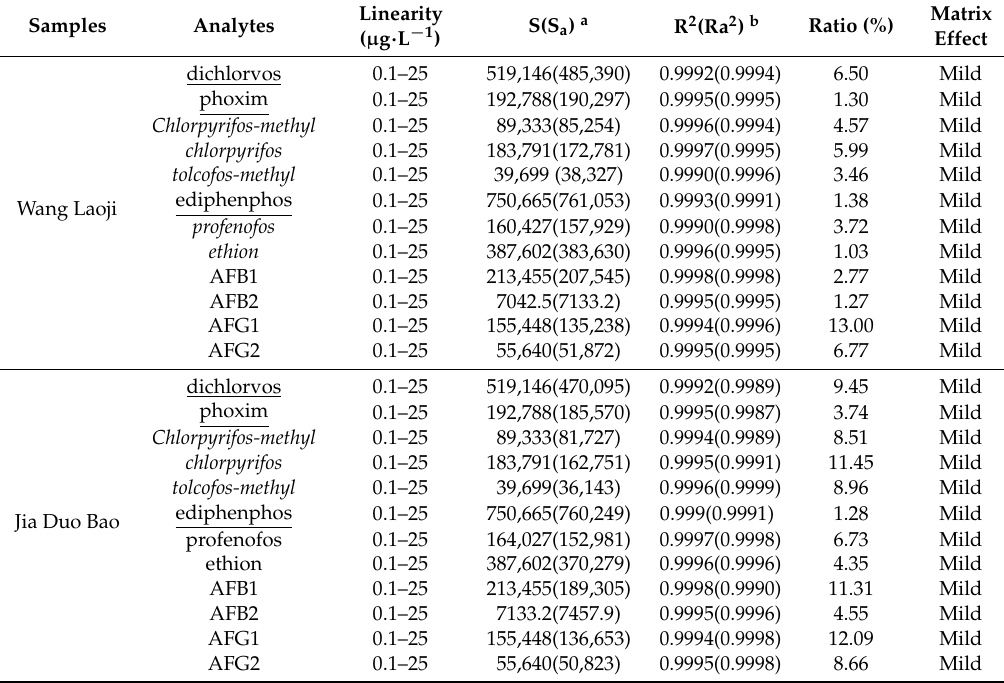
Table 4. Calibration data of the DLLME procedure for pesticide and mycotoxins in Wang Lo Kat and Jia Duo Bao